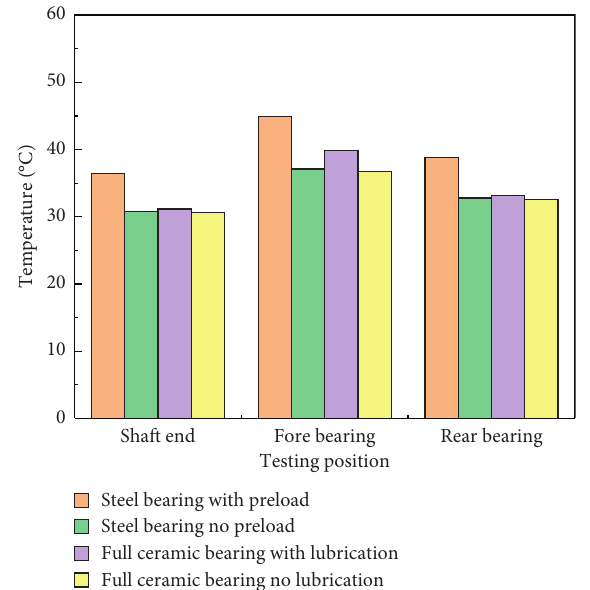
Figure 16: Temperature rise comparison of Si bearings and steel bearings under grease lubrication